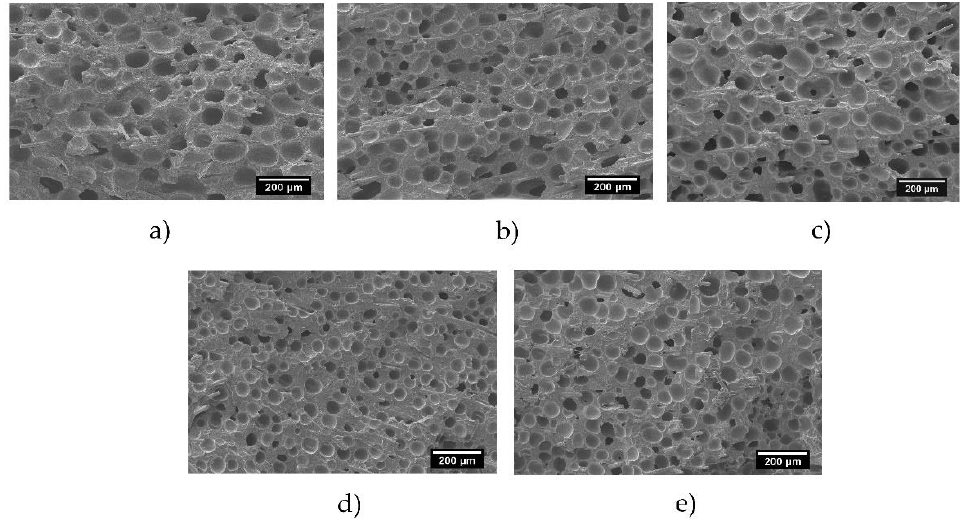
Figure 2. Scanning electron microscopy (SEM) micrographs of several obtained samples: ( a ) long-chain branched polypropylene (LCB-PP) 0% ( b ) LCB-PP 25% ( c ) LCB-PP 50% ( d ) LCB-PP 75% ( e ) LCB-PP 100%. The scale bar represents 200 μm.